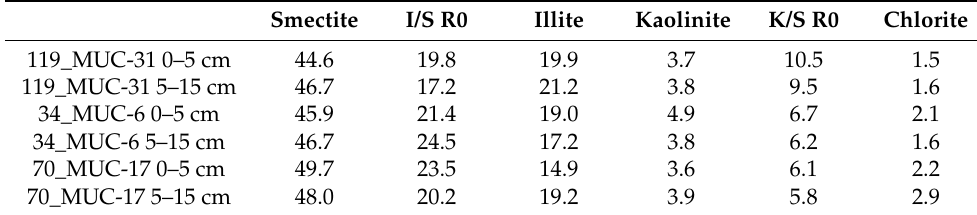
Table A3. Quantitative clay composition of the <2 µ m fraction of pre-treated samples in wt%.